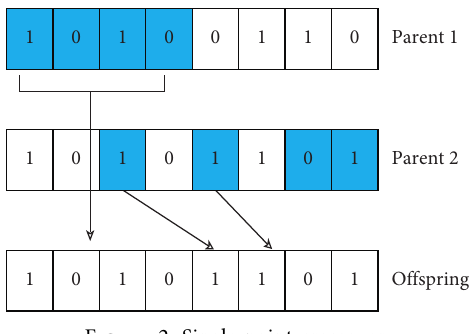
Figure 2: Single-point crossover.